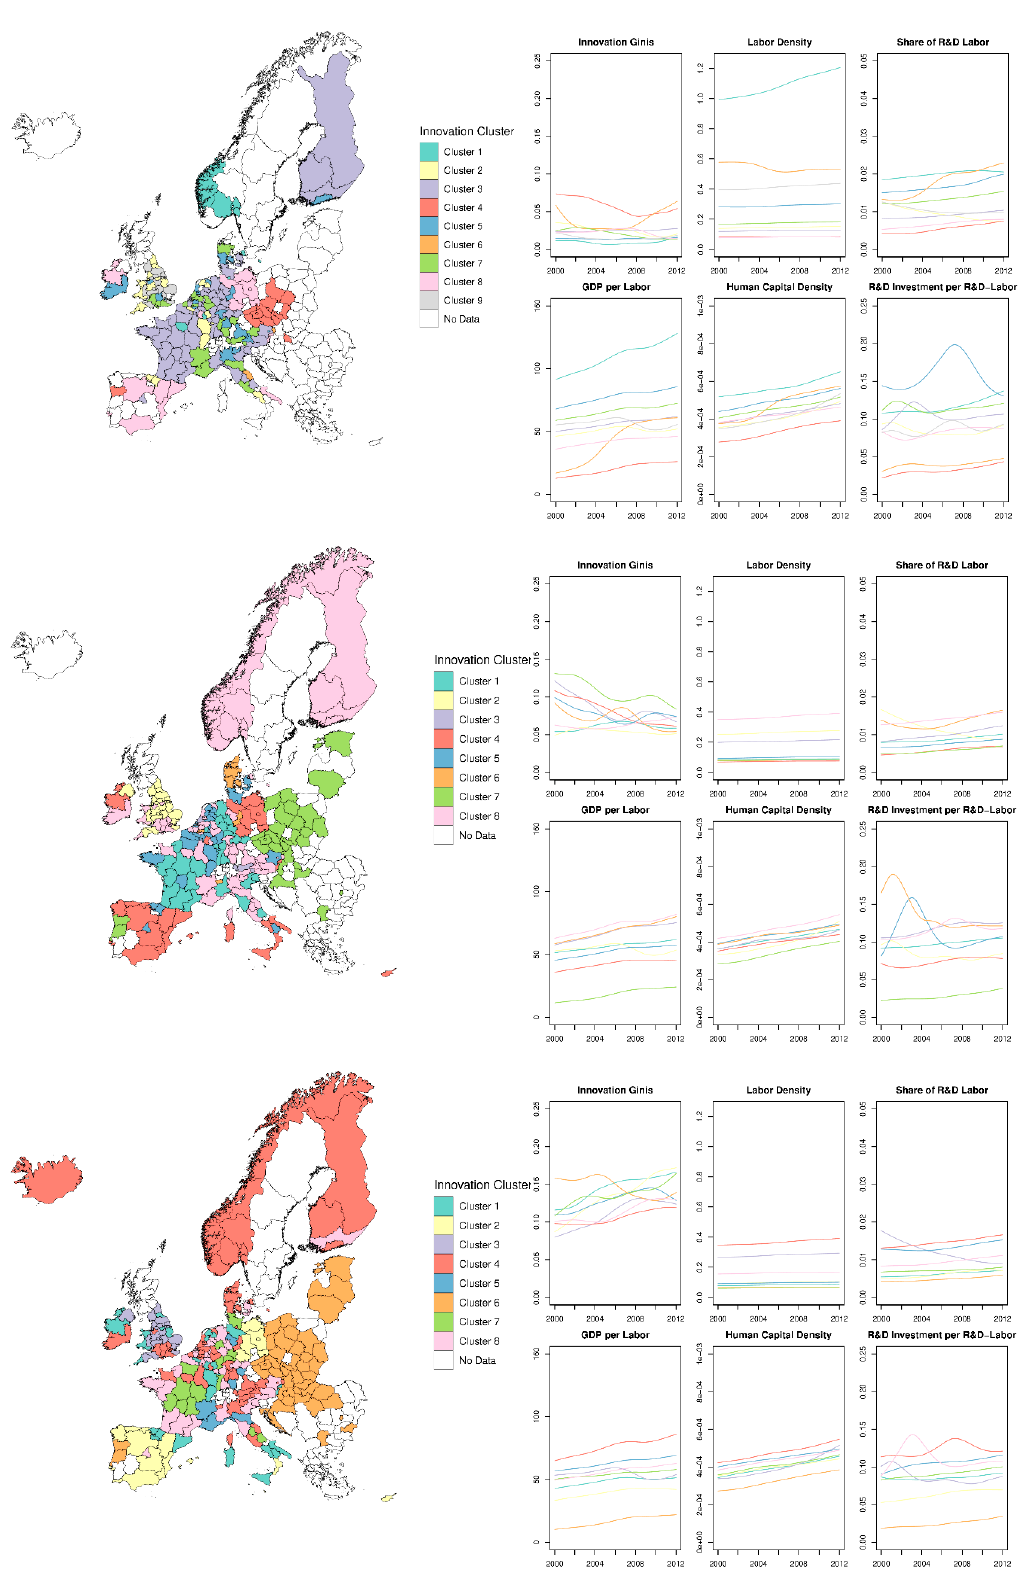
Figure 2. Results of the mixture model-based multivariate functional clustering algorithm. Rows: IPC classes D, E, and F (D: ‘textiles and paper’; E: ‘fixed constructions’; F: ‘mechanical engineering, lighting, heating, weapons, and blasting’). Columns: left: Spatial cluster mapping, right: Temporal cluster dynamics. Source: Own calculations.